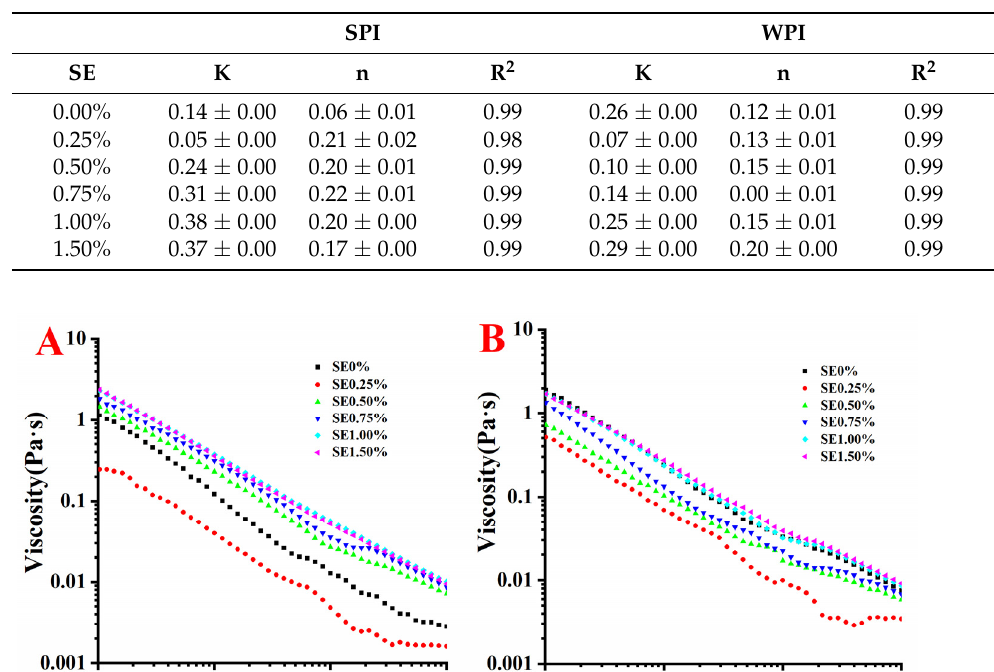
Table 2. Parameters of Ostwald–Dewaele model fitting (K: slope; n: dimensionless; R 2 : variance).